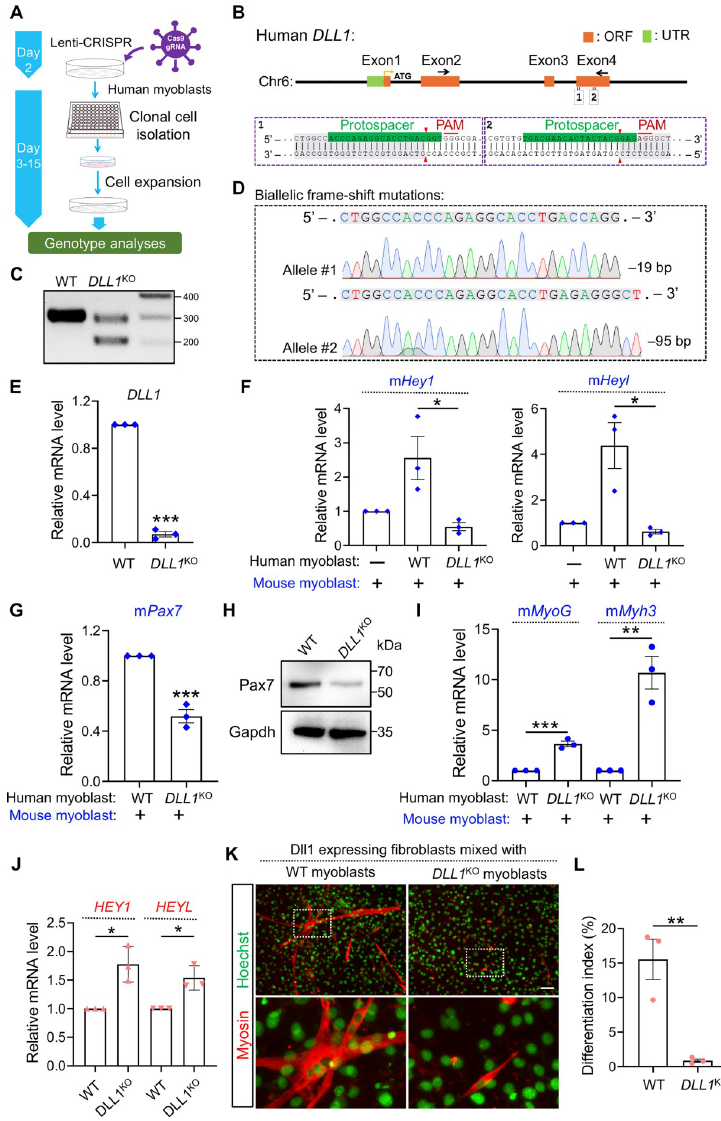
Fig 4. DLL1 loss-of-function study in human myoblasts. ( A ) Schematic of CRISPR/Cas9 approach to generate gene- knockout clones from human myoblasts. ( B ) Schematic of human DLL1 gene structure and the sequences of gRNAs in exon 4. ( C ) DNA electrophoresis results of DLL1 genotyping PCR. ( D ) Sanger sequencing analysis of human DLL1 genotyping PCR products. The premature stop-codon was detected in exon 5 and exon 7 for the –95 bp and –19 bp allele, respectively. ( E ) qPCR results of DLL1 measured using primers located in exon 3 (forward) and exon 4 (reverse). DLL1 has total 11 exons. ( F , G ) qPCR results for genes in mouse myoblasts that were co-cultured with human myoblasts of indicated genotypes. ( H ) Western blotting analysis of protein lysates from mixing culture of mouse/ human myoblasts. Note that the immortalized human myoblasts do not express Pax7. ( I ) qPCR results for genes in mouse myoblasts that were co-cultured with human myoblasts of indicated genotypes. ( J ) qPCR results that measured HEY1 and HEYL expression in WT or DLL1 KO human myoblasts after co-culturing with Dll1+ fibroblasts. ( K ) Myosin immunostaining of human myoblasts. ( L ) Quantification of myosin+ cells as in panel K. n = 3. Data are means ± SEM. � P < 0.05, �� P < 0.01, ��� P <